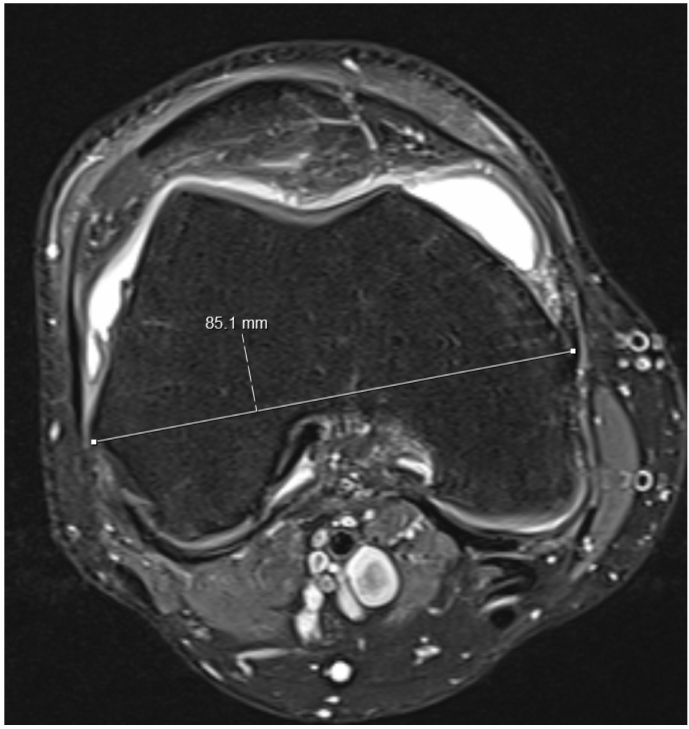
Figure 3. The largest axial femur diameter was measured at the level of the condyles as indicated in the